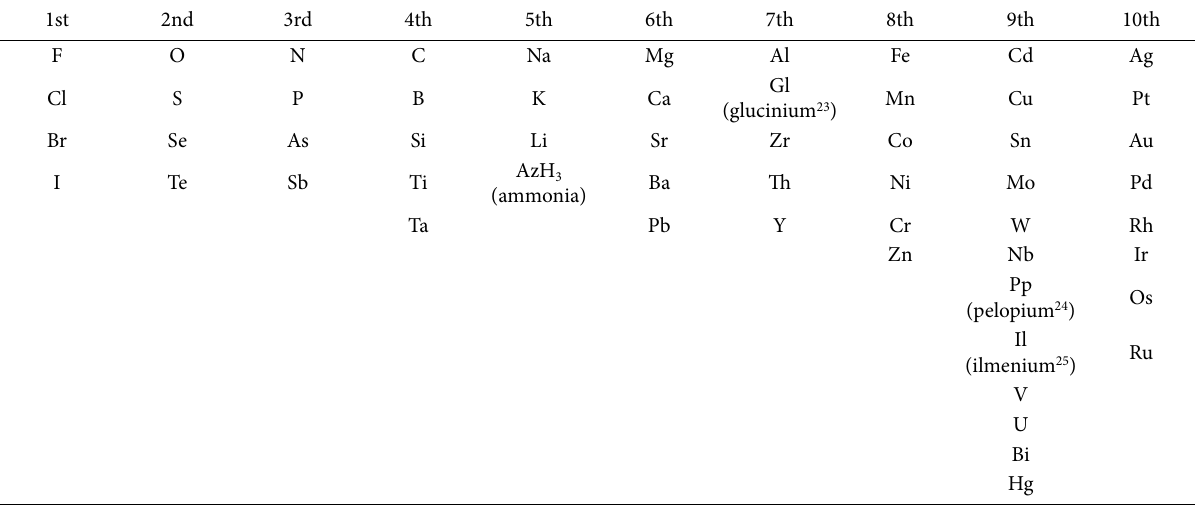
Table 1. Authors’ table of the ten natural families as they are described in J. M. O. Pimentel’s book (ref.